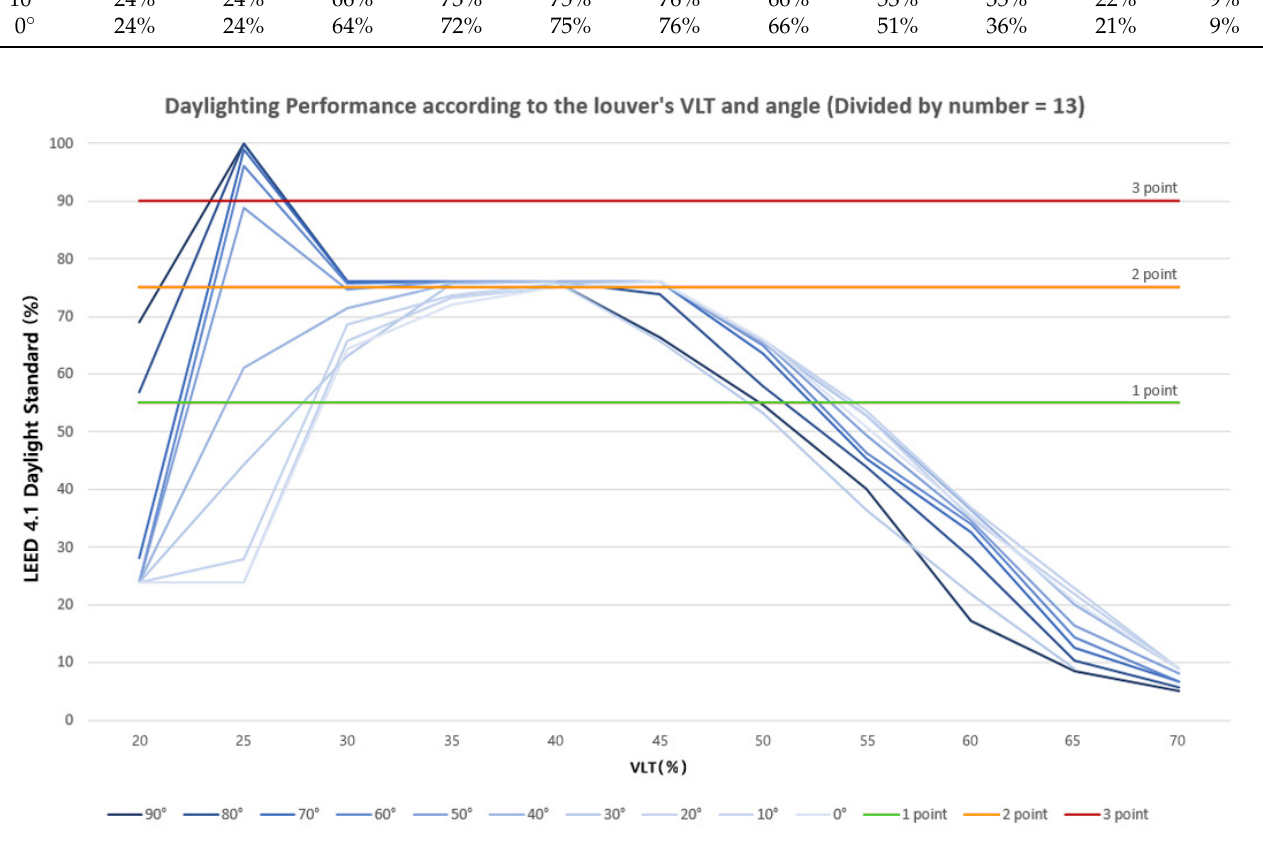
Figure 8. Target illuminance achievement rate graph when the number of divisions of louvers is 13. When the number of louvers is 14, target illuminance achievement rate results are shown in Table 8 and Figure 9. There are four cases where three points could be obtained, just like when the number of louvers was 11, 12, or 13. There were 35 cases in which two points could be obtained. A total of 39 cases in which two or more points could be